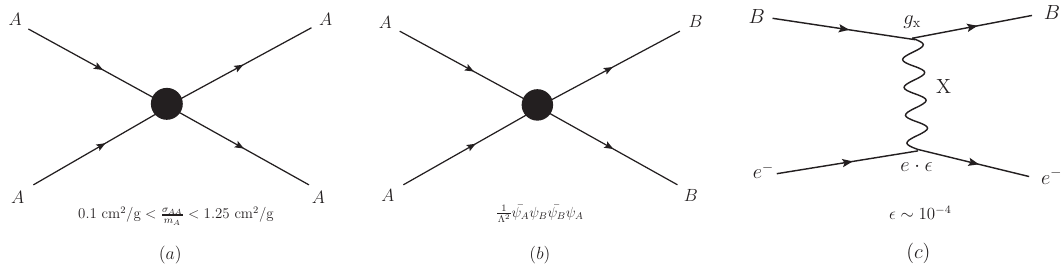
Figure 1 . Diagrams for (a) self-interaction of the heavier DM component A , (b) production of the boosted DM B from the annihilation of A , and (c) elastic scattering of B o(cid:11) an electron. lighter subdominant DM component B directly couples to the SM sector. The